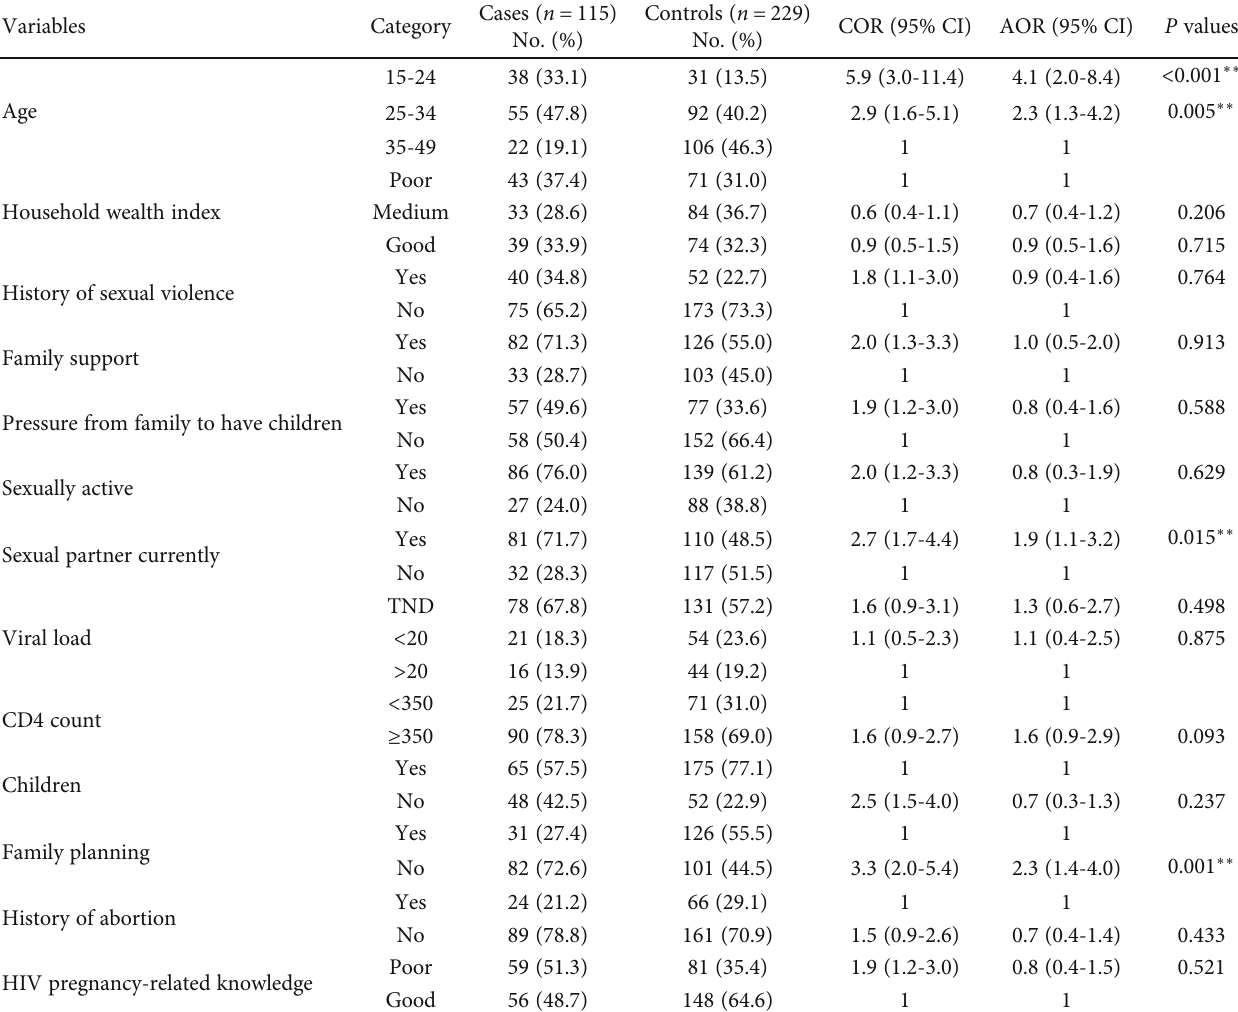
Table 5: Multivariable analysis of factors associated with fertility desire among women living with HIV attending ART in Jimma University Medical Center, 2019 ( N = 344